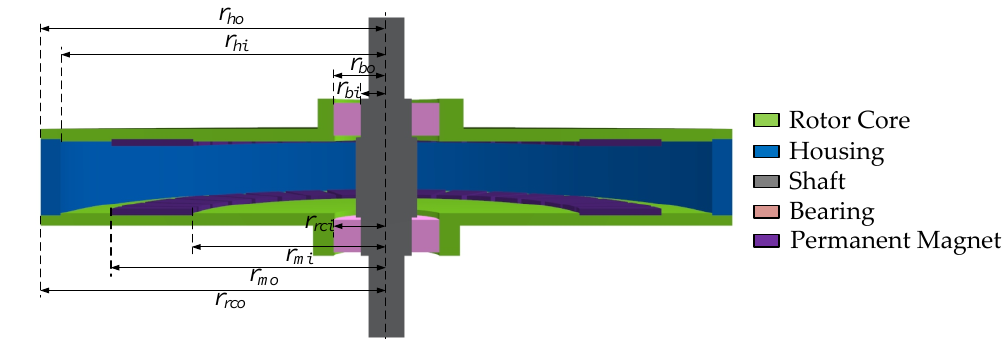
Figure 12. Cross-section of the YASA machine.